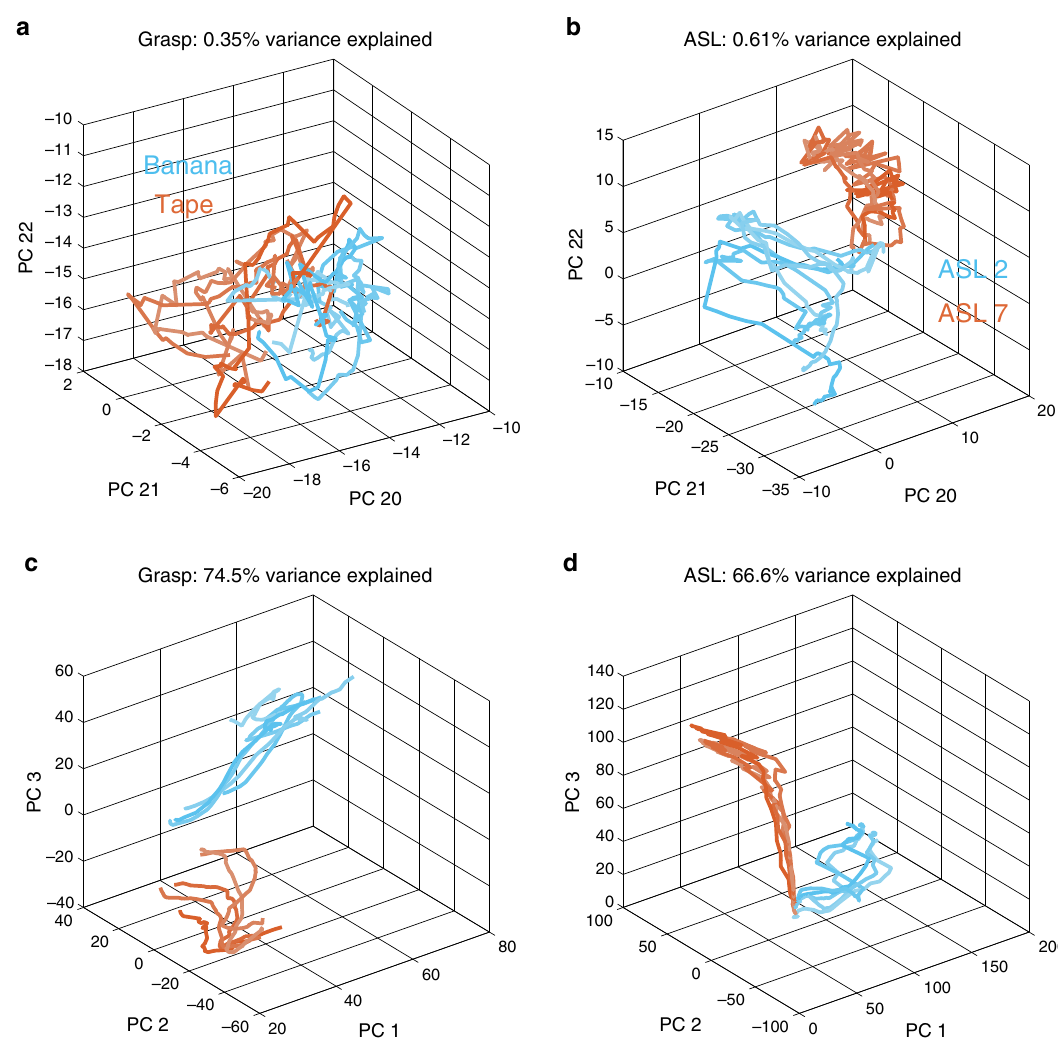
Fig. 4 Object-speci fi c kinematics in PC subspaces. a Projection of the kinematics onto PCs 21 through 23 for fi ve grasps each of tape and banana. b Projection of the kinematics onto PCs 21 through 23 for fi ve repeated signs each of “ two ” and “ seven ” in ASL. c Projection of the kinematics onto PCs 1 through 3 for the conditions shown in a . d Projection of the kinematics onto PCs 1 through 3 for the conditions shown in b . In all panels, separate objects and signs are indicated by color, and different trials are indicated by traces of different